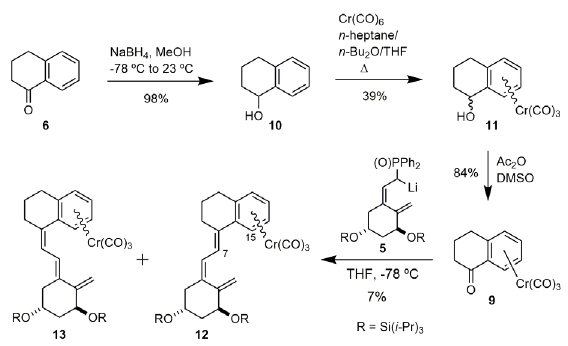
-complexation on the Wittig- 3